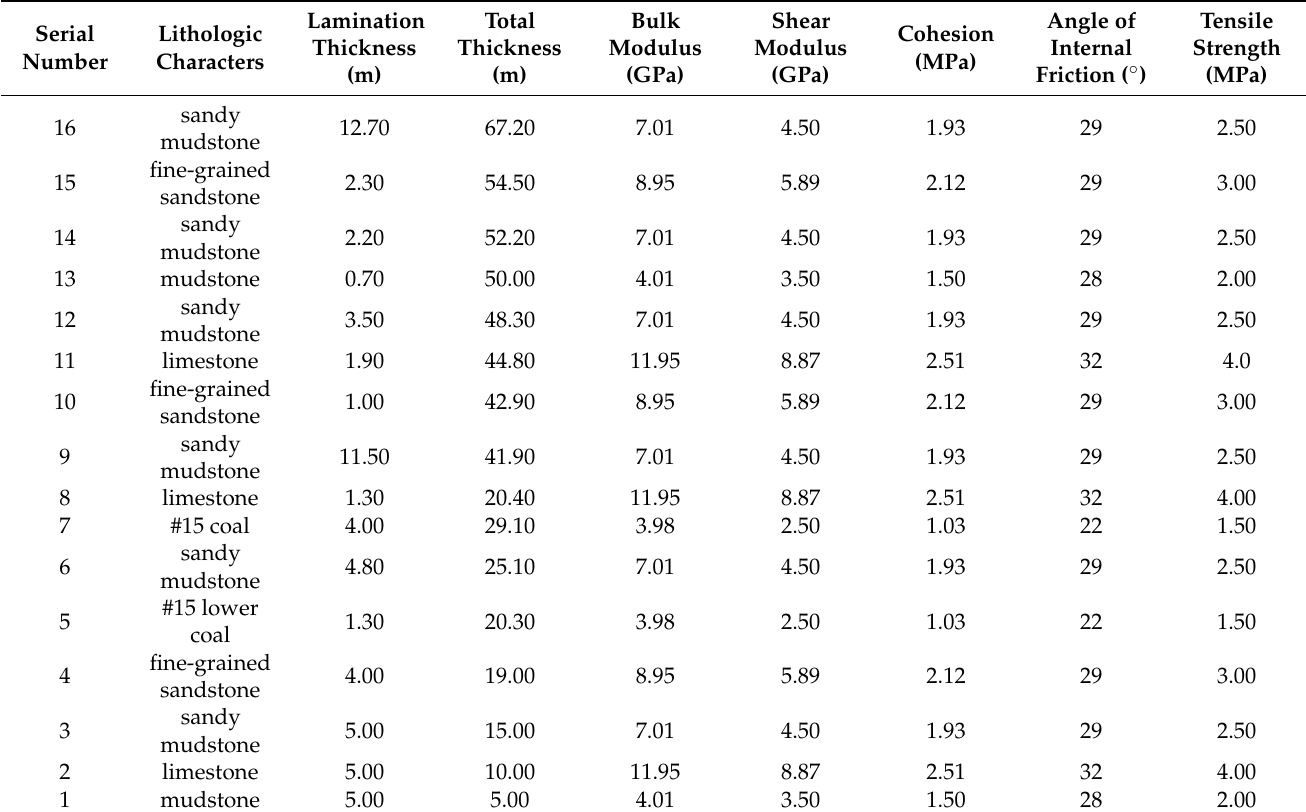
Figure 7. Numerical simulation model diagram. Table 3. Rock mechanics parameters.